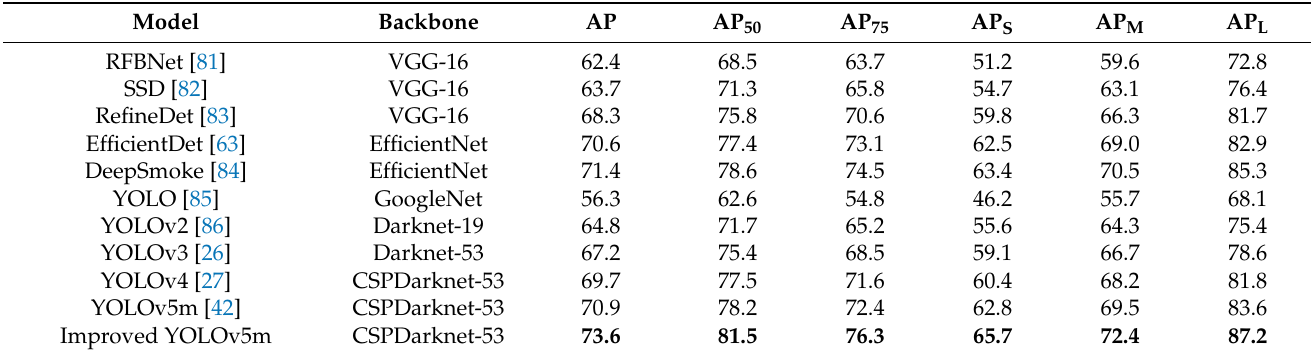
Table 10. The proposed method versus other one-stage object detectors on the custom wildfire smoke dataset test-set. Improved YOLOv5m outperforms all one-stage object detectors.